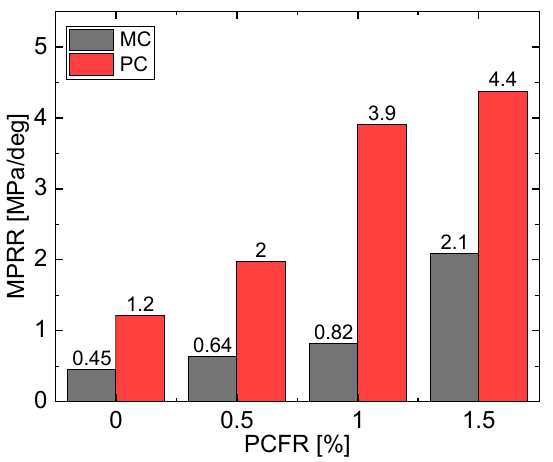
Figure 19. Predicted MPRR for ST = − 2 CAD, CR = 14, and λ = 4 using different PCFRs.